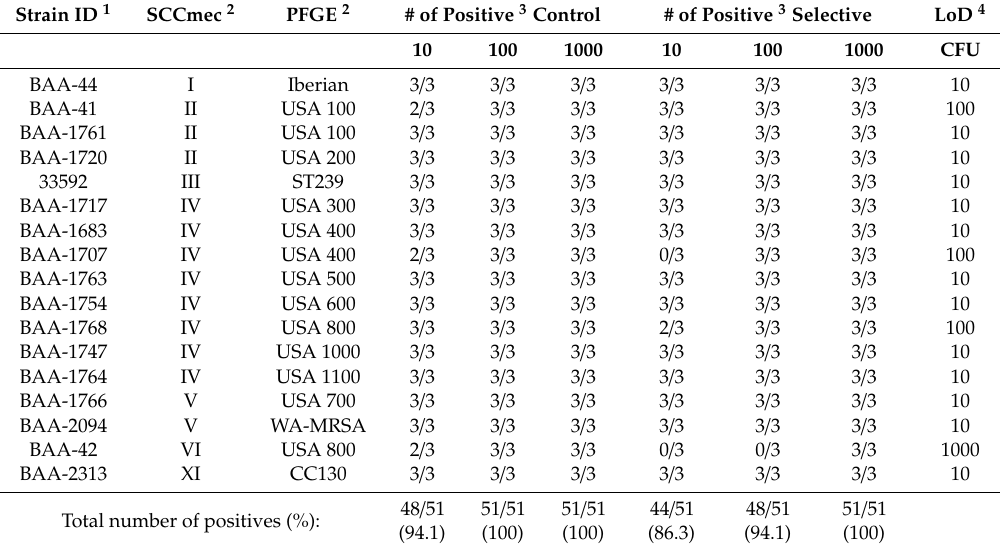
Table 1. In Vitro sensitivity and